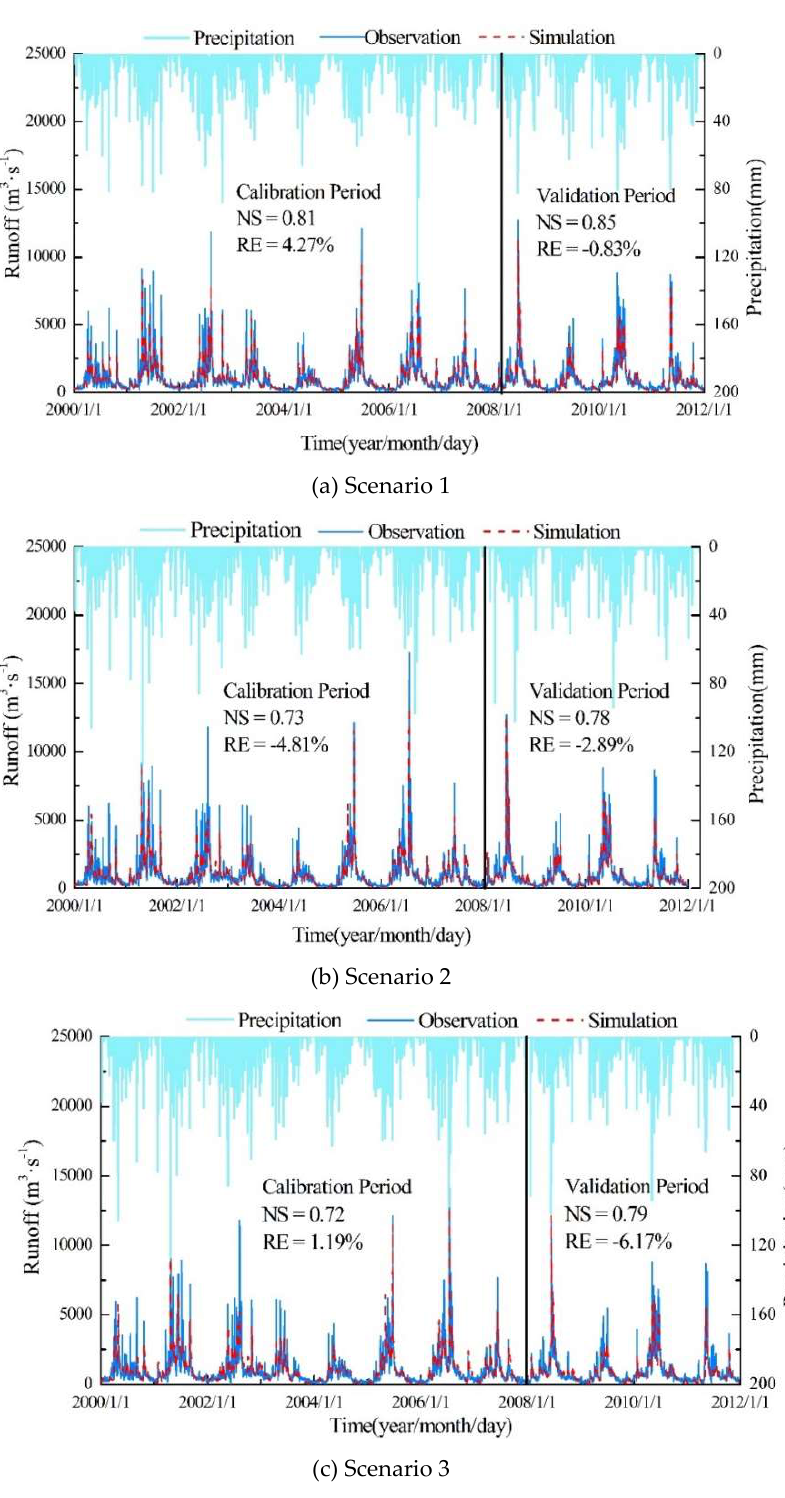
Figure 6. Runoff calibration and validation processes in the Feilaixia catchment under the three scenarios: (a) Scenario 1; (b) Scenario 2; and (c) Scenario 3.